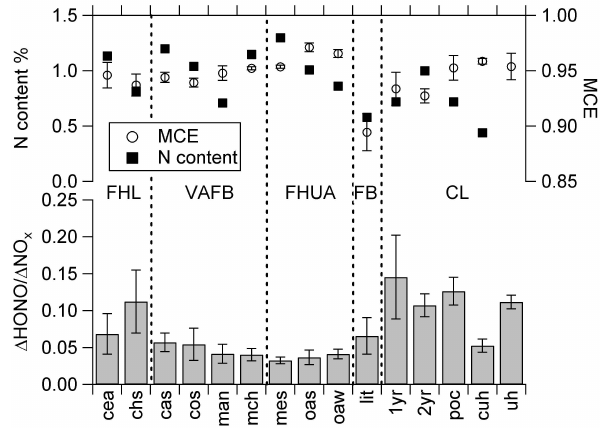
Fig. 7. 1 HONO/ 1 NO x molar emission ratios for various fuel types. The fuel types are ordered from west to east from left to right. MCE (circles) and fuel nitrogen content fraction (squares) are shown in the upper portion of the plot. See Table 1 for fuel descriptions.